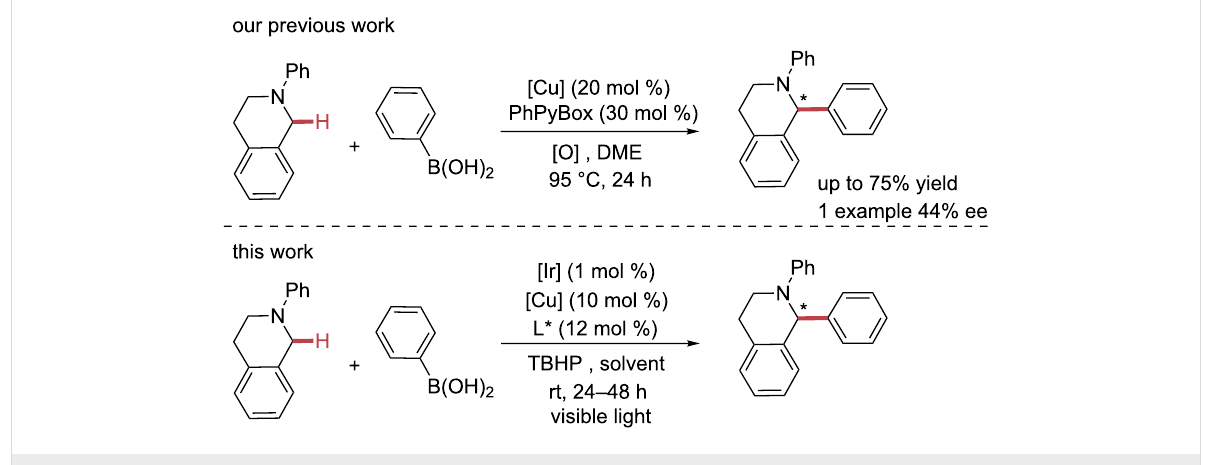
Scheme 1: Design light-mediated arylation of